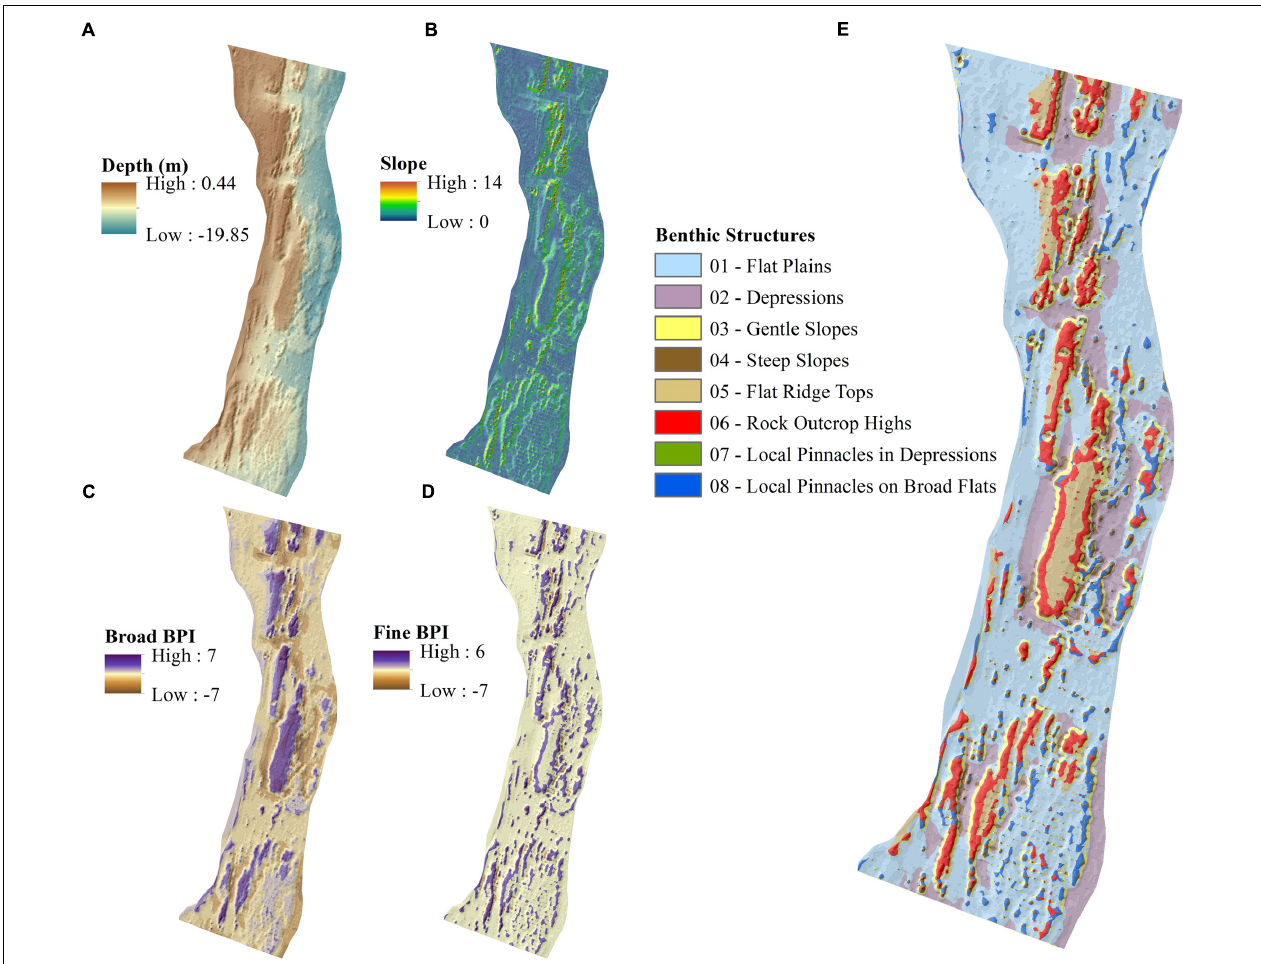
TABLE 2 | Depth-related description of the geomorphological classification and the percentage of occurrence.